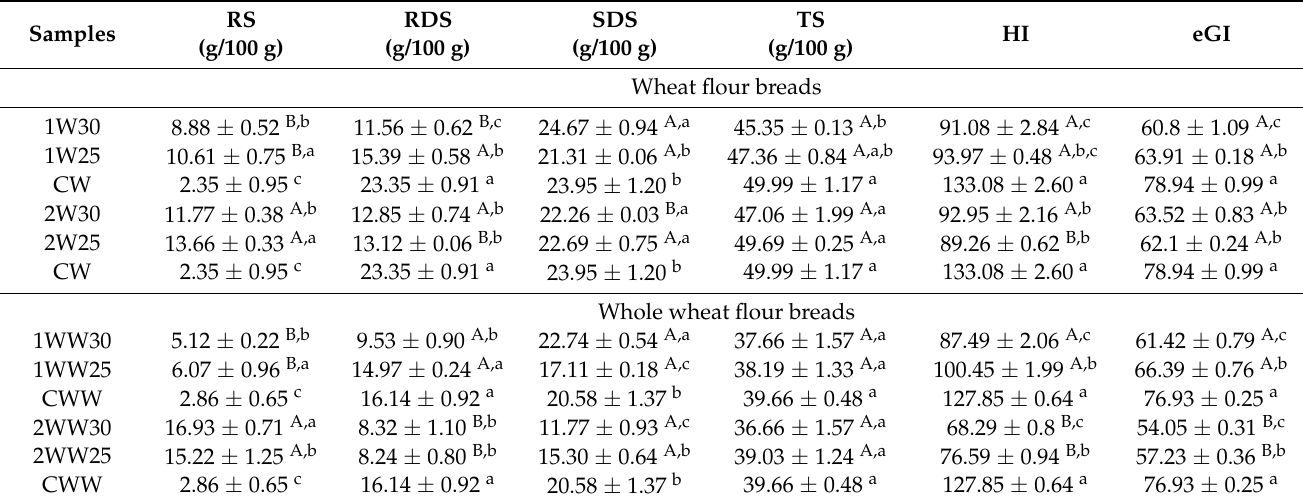
Table 6. Starch fractions of bread